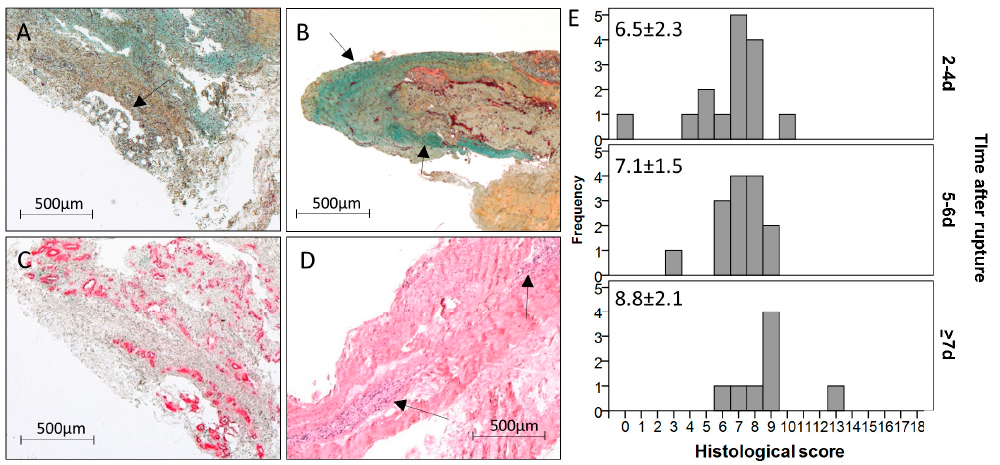
Figure 2. Exemplary pictures of acute ruptured Achilles tendon samples showing ( A ) fat tissue (black arrow, MP staining, 10-days-old rupture), ( B ) high GAG content stained in turquoise (black arrows, MP staining, 2-days-old rupture), ( C ) massive vascularity visualized by α -SMA staining (10-days-old rupture), and ( D ) large cell clusters visualized by H&E staining (black arrows, 5-days-old rupture). Scale bar: 500 μ m. ( E ) Histogram showing the frequency of points of the histological score over the three time-point groups. The score increased from the early to the late time point ( p = 0.023) and from the middle to the late time point ( p = 0.050) after rupture. However, differences did not stay significant after Bonferroni–Holm correction.